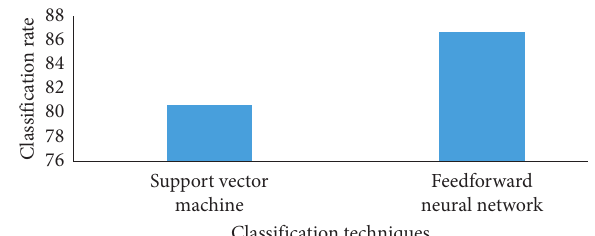
Figure 13: Proposed model loss.